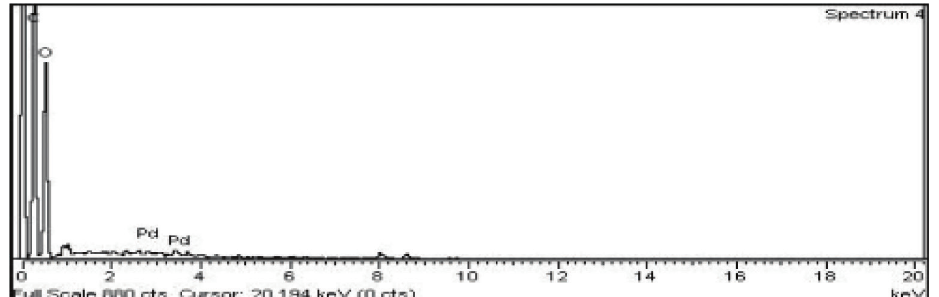
Figure 8: The EDX pattern of the synthesized palladium nanoparticles.